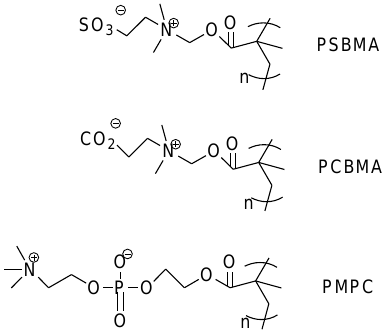
Figure 9. Chemical structure of three representative polybetaines, poly(2-methacryloyloxyethyl phosphorylcholine) (PMPC), poly(carboxybetaine methacrylate) (PCBMA) and poly(sulfobetaine methacrylate) (PSBMA) [58].